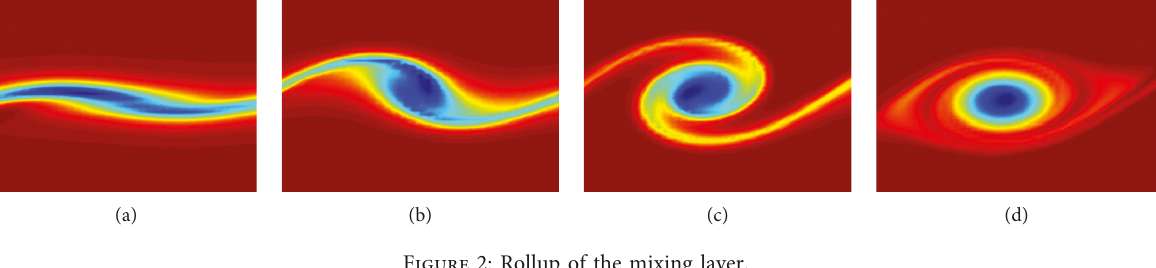
Figure 2: Rollup of the mixing